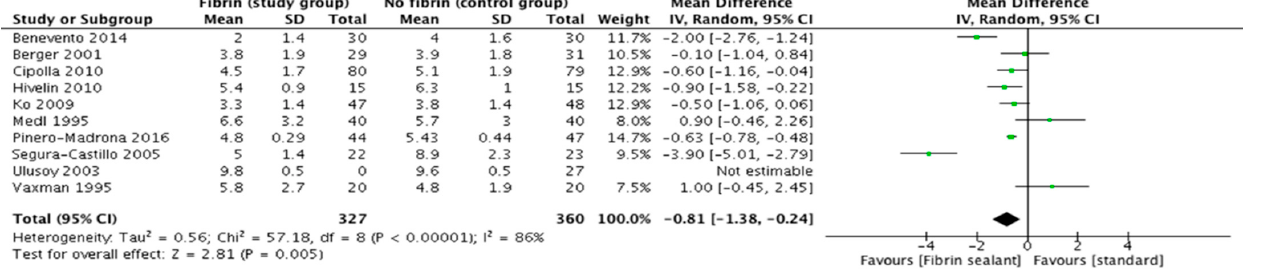
Figure 6. Number of days before removal of axillary drainage.